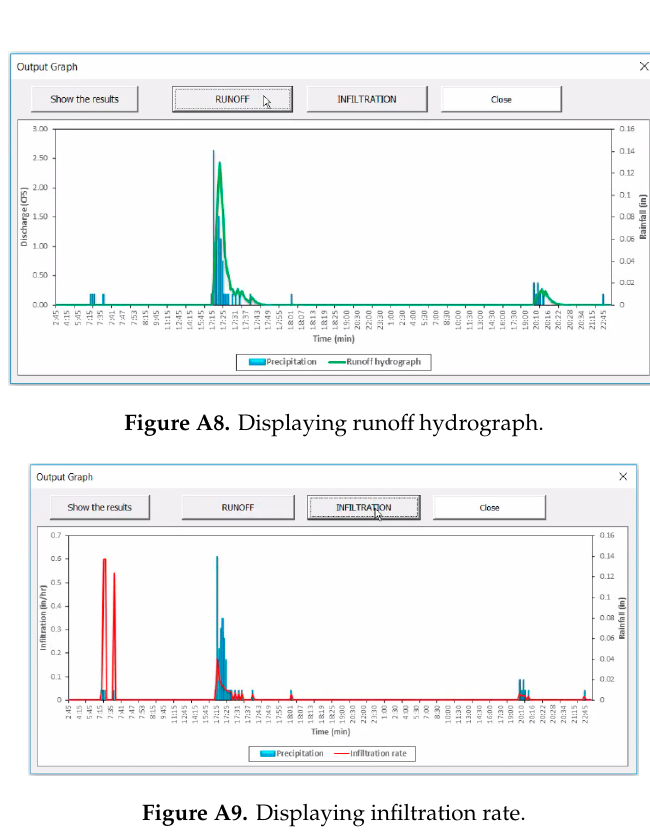
Figure A7. Defining soil type and watershed parameters